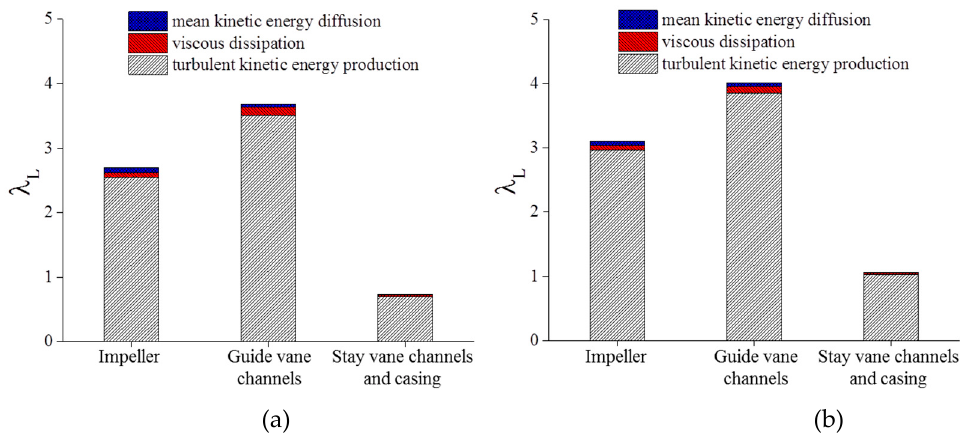
Figure 18. Composition of the loss coefficient at conditions ( a ) IV and ( b ) III.